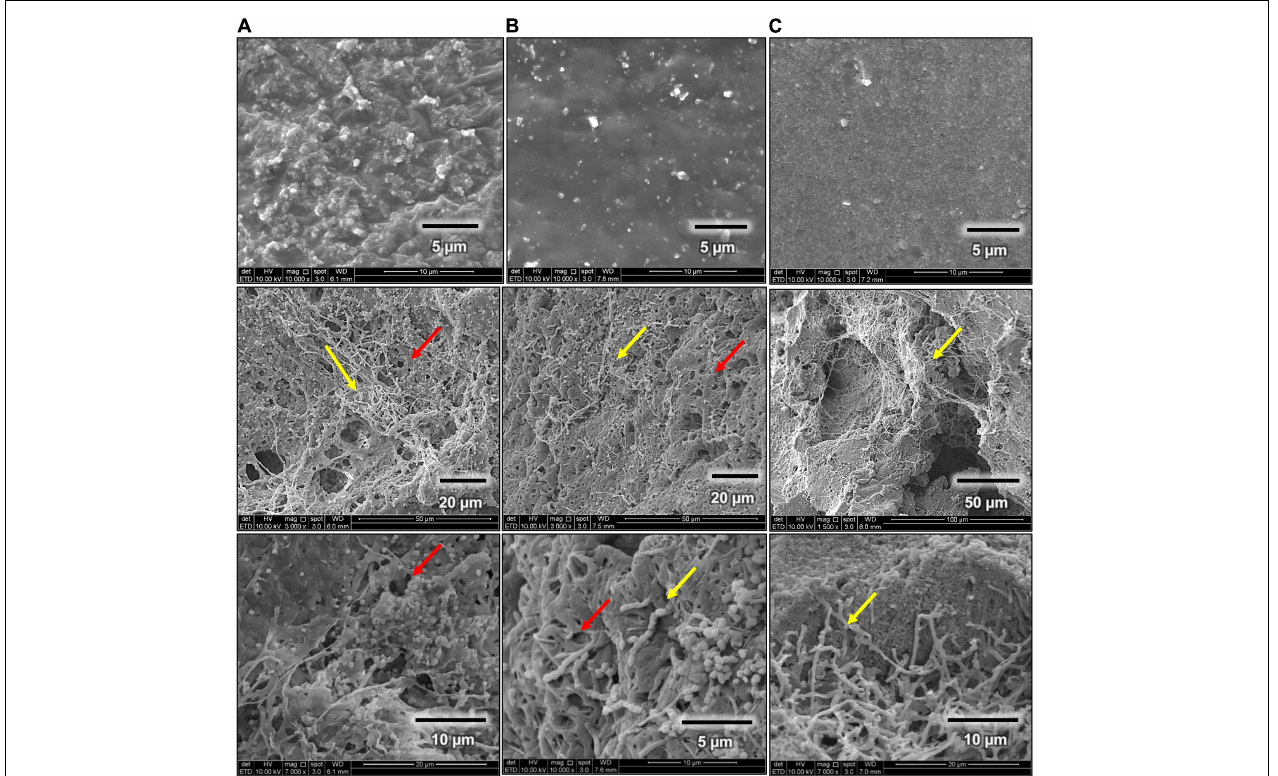
FIGURE 6 | Scanning electron micrographs (SEM Quanta FEG 650) of rubber utilization studies in MSM broth for 60 days at 28 ◦ C and 180 rpm, before (first row) and after 60 days (second and third rows). (A) Fresh latex pieces, (B) latex glove strips, and (C) tire